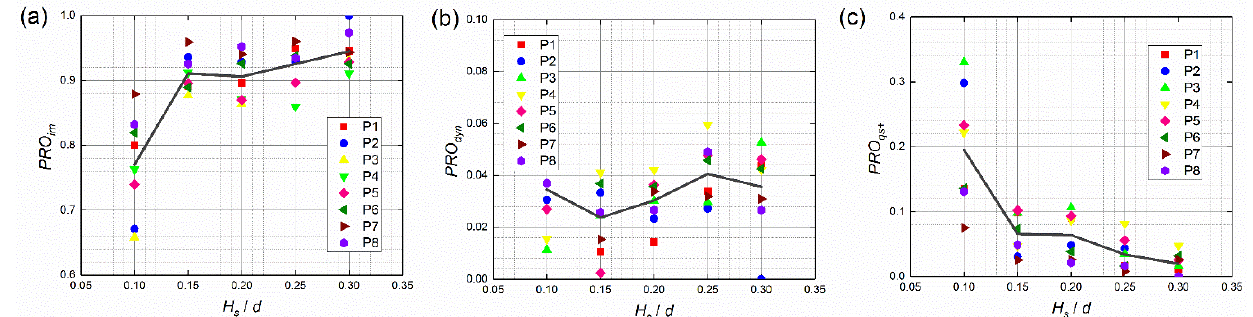
Figure 10. Influence of relative wave height on the probabilities of three types of wave impact on horizontal slab for structural clearance of 0.02 m (trials T21 – T25): ( a ) impulsive probability PRO im ; ( b ) dynamic probability PRO dyn ; ( c ) quasi-static probability PRO qs+ .